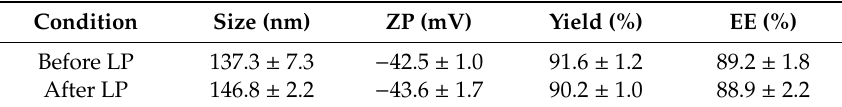
Table 4. Influence of the lyophilization process on particle size, zeta potential, yield, and encapsulation efficiency of the SCF-CO 2 .